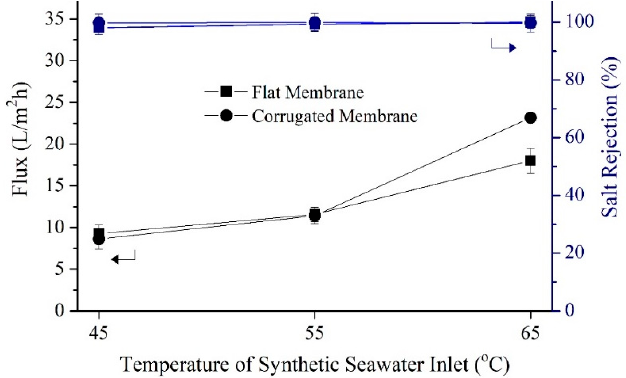
Figure 7. Short-term performance of flat and corrugated PVDF membranes in treating synthetic seawater (35 g/L of NaCl in deionized water) solution at different feed temperatures. The cold stream was maintained at 25 °C and both hot and cold streams were pumped at a constant linear velocity of 2.2 cm/s.